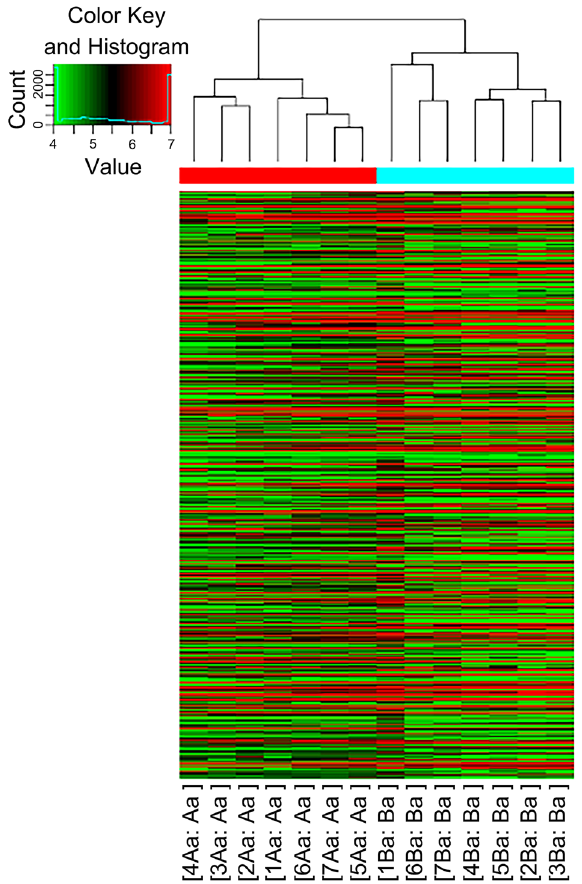
Figure 2. The dendrogram. The meniscal degeneration group is shown in cyan blue, while the control group is shown in